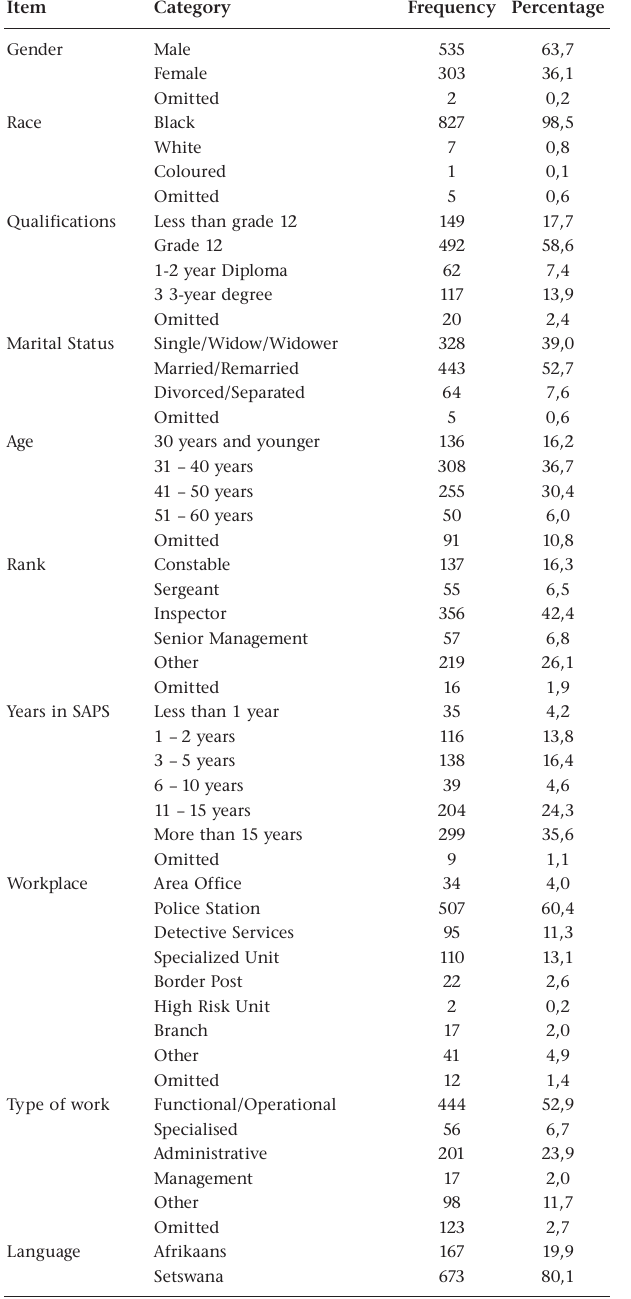
table 2 characteristics of the participants (n =